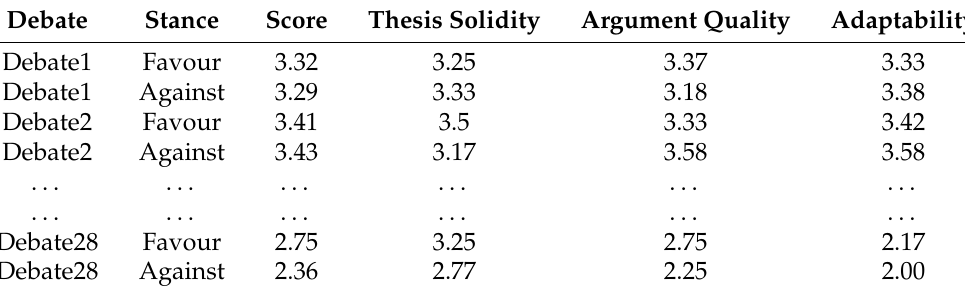
Table 3. Structure of the VivesDebate evaluation file.